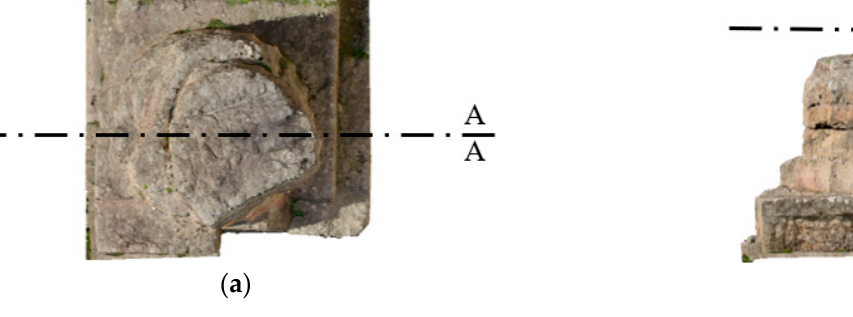
Figure 13. Sections of the scan closure zones: section at the closure of the scan of the lateral surface ( a ), section at the vertical closure of the scan on the third column drum ( b ).